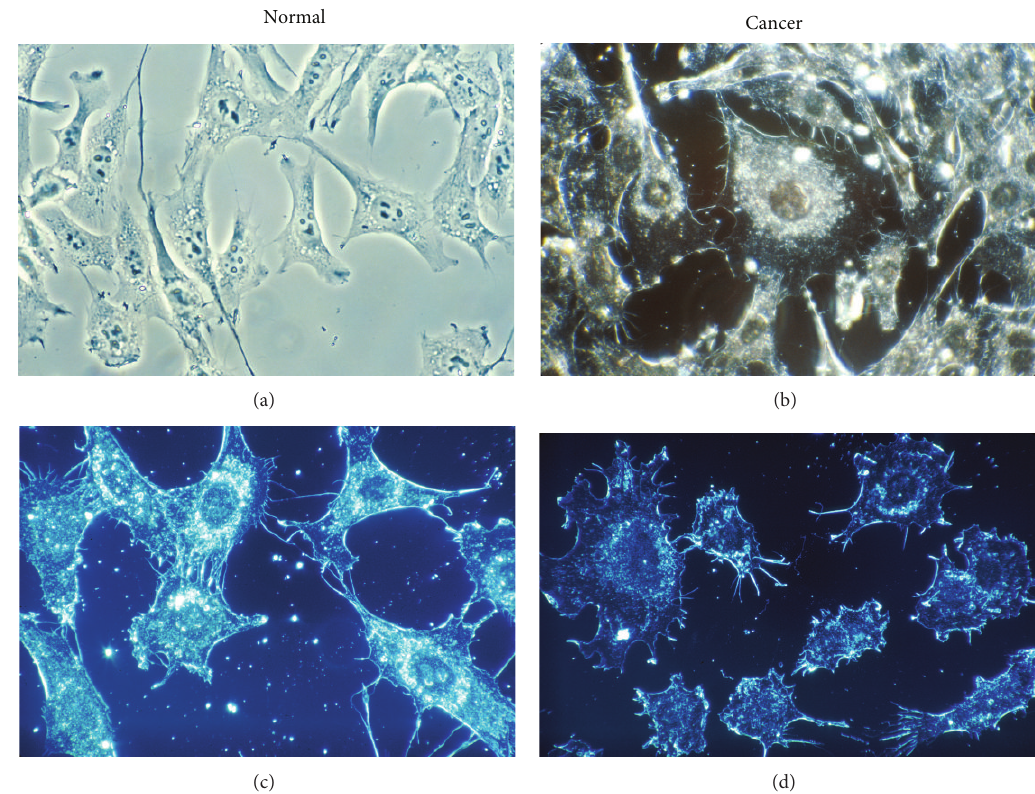
Figure 7: Normal cells on the left and cancer cells with more spike-like membrane extensions on the right in culture from human connective tissue. At a magnification of 500x, the cells were illuminated by darkfield amplified contrast technique. (a) Normal cells compared to (b) cancer cells. (c) Normal Cells compared to (d) cancer cells (with permission from the National Institutes of Health/Department of Health and Human